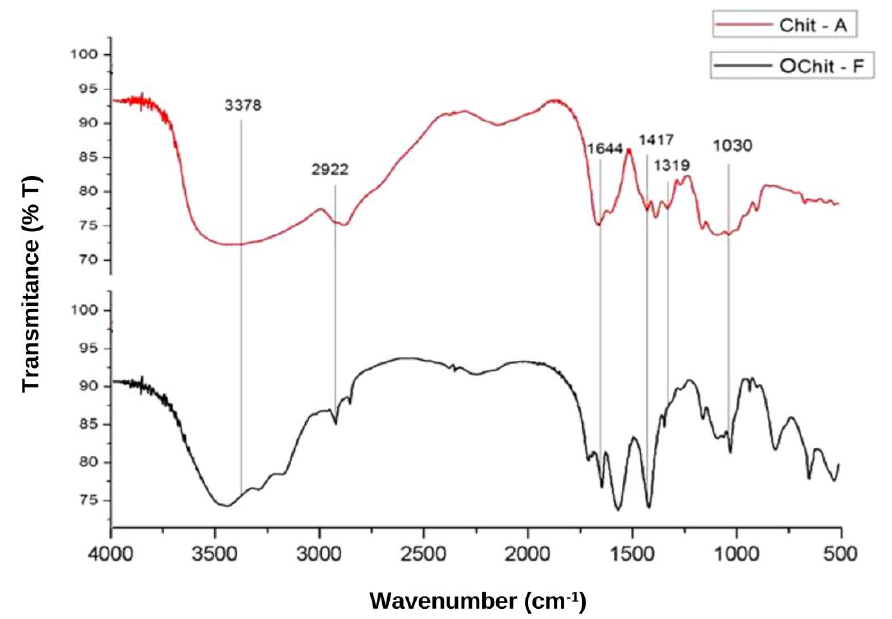
Figure 1. FT-IR spectrum of chitosan from C. elegans with the characteristic bands in evidence. The results of X-ray diffraction of the fungal oligochitosan extracted from C. elegans (Figure 2) showed a peak at approximately 20°, corresponding to the crystalline region of the compound, and another at 9°, corresponding to the amorphous chitosan region.